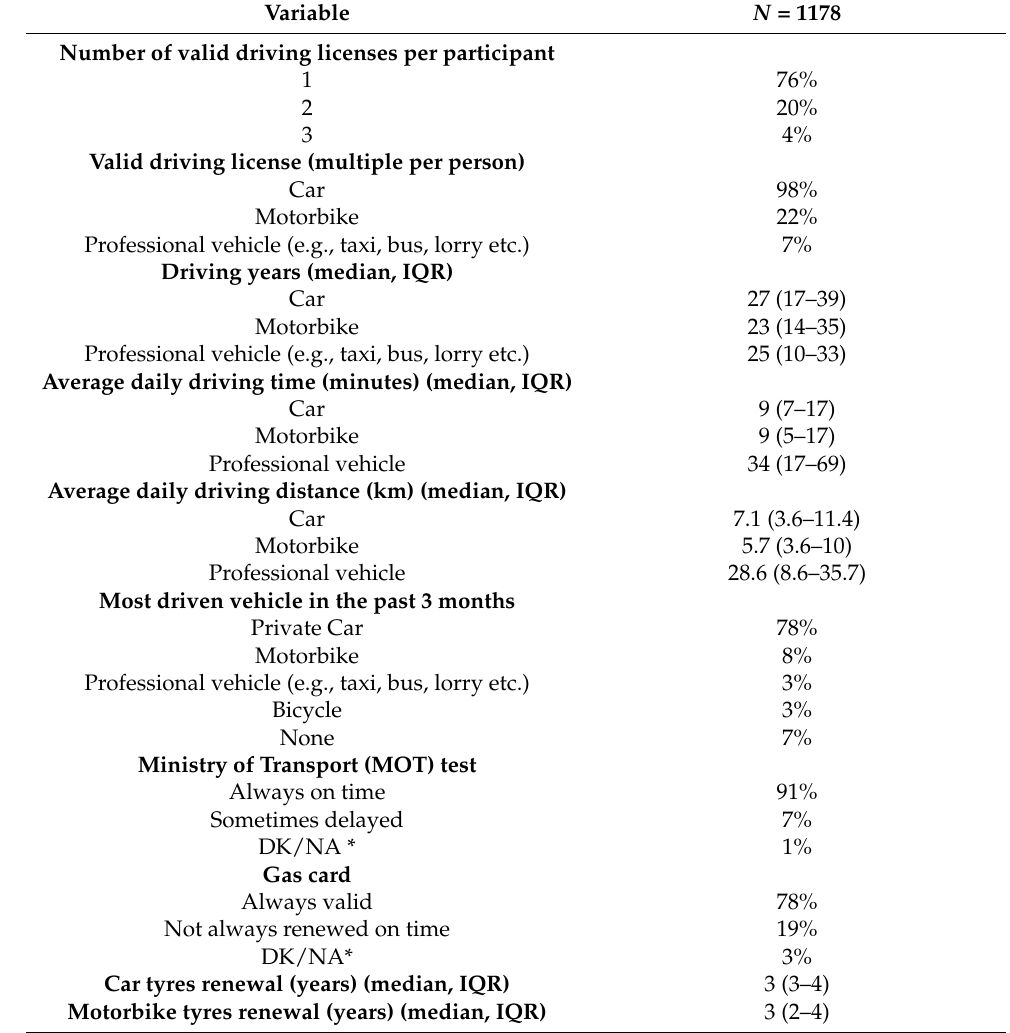
Table 3. Characteristics of participants with at least one valid driving license.